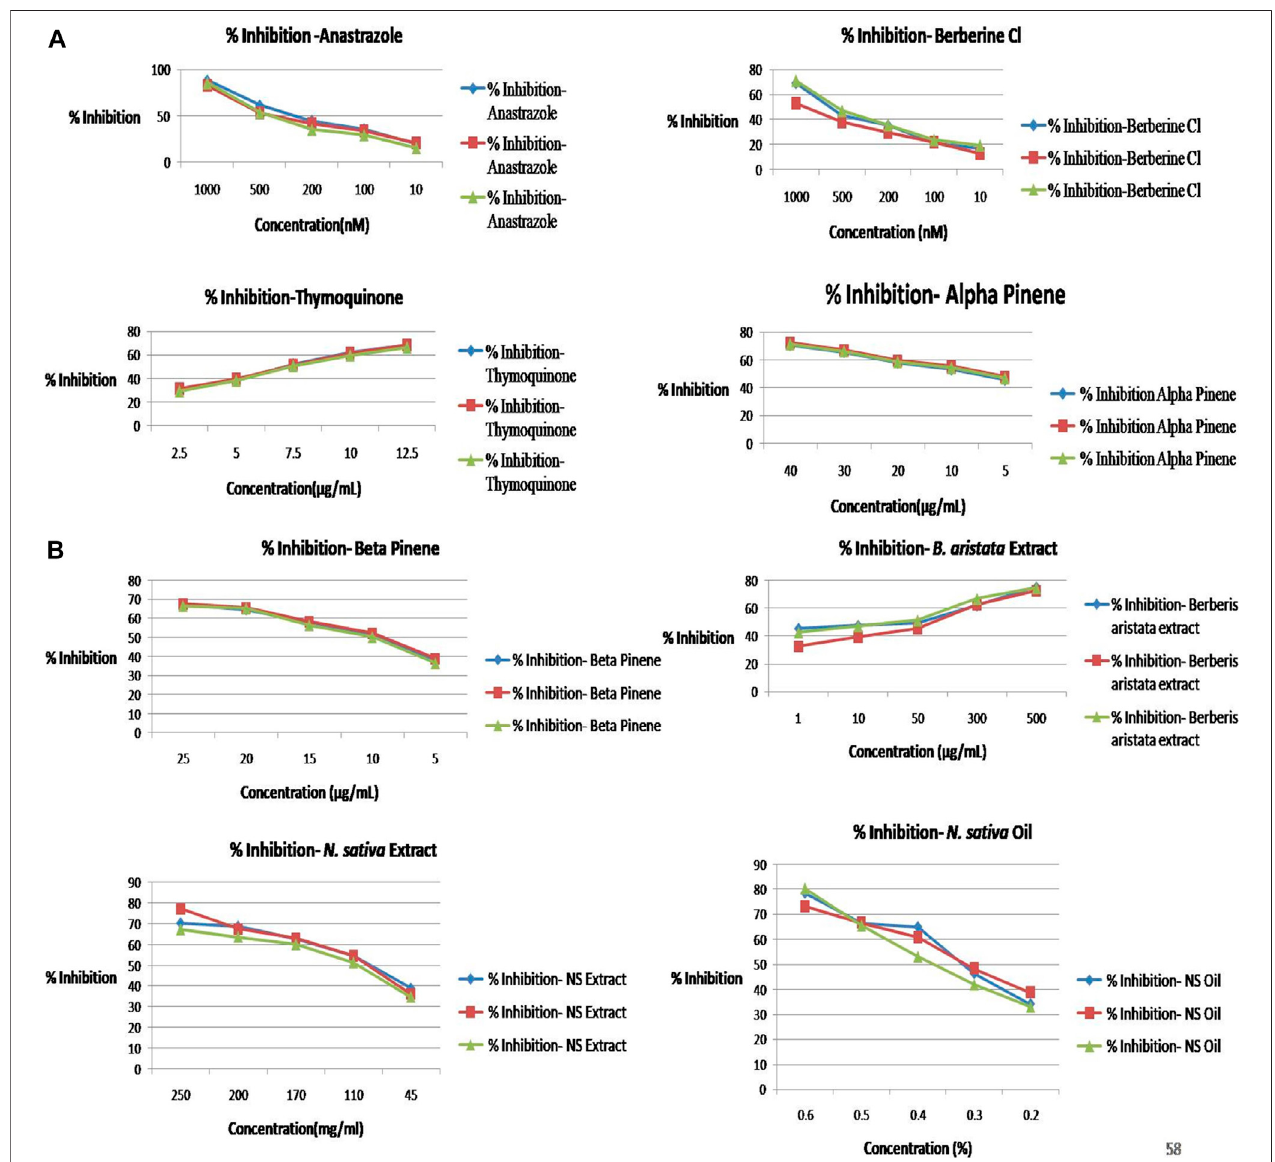
FIGURE 3 | (A) Percentage inhibition vs concentration graphs. (B) Percentage inhibition vs concentration